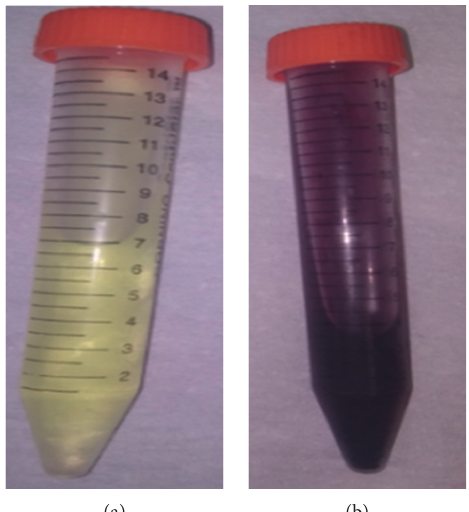
Figure 2: Images illustrating the color change of PEG-gold chloride solution from pale yellow (a) to ruby red (b) to confirm the synthesis of gold nanoparticles.